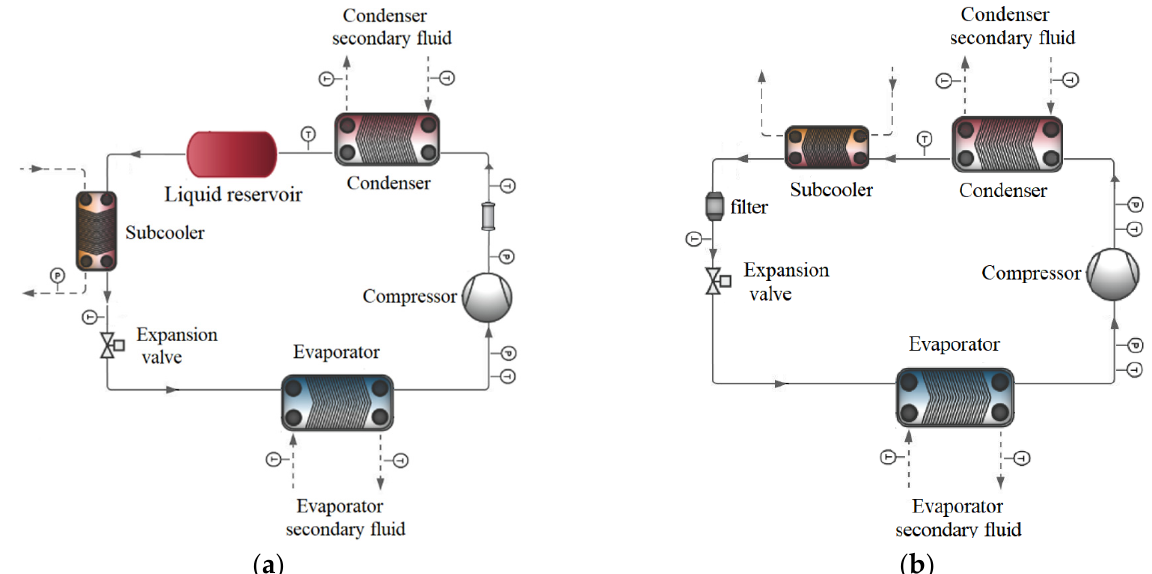
Figure 4. Schematic of the supermarket refrigeration system: ( a ) LT and ( b ) MT circuits.